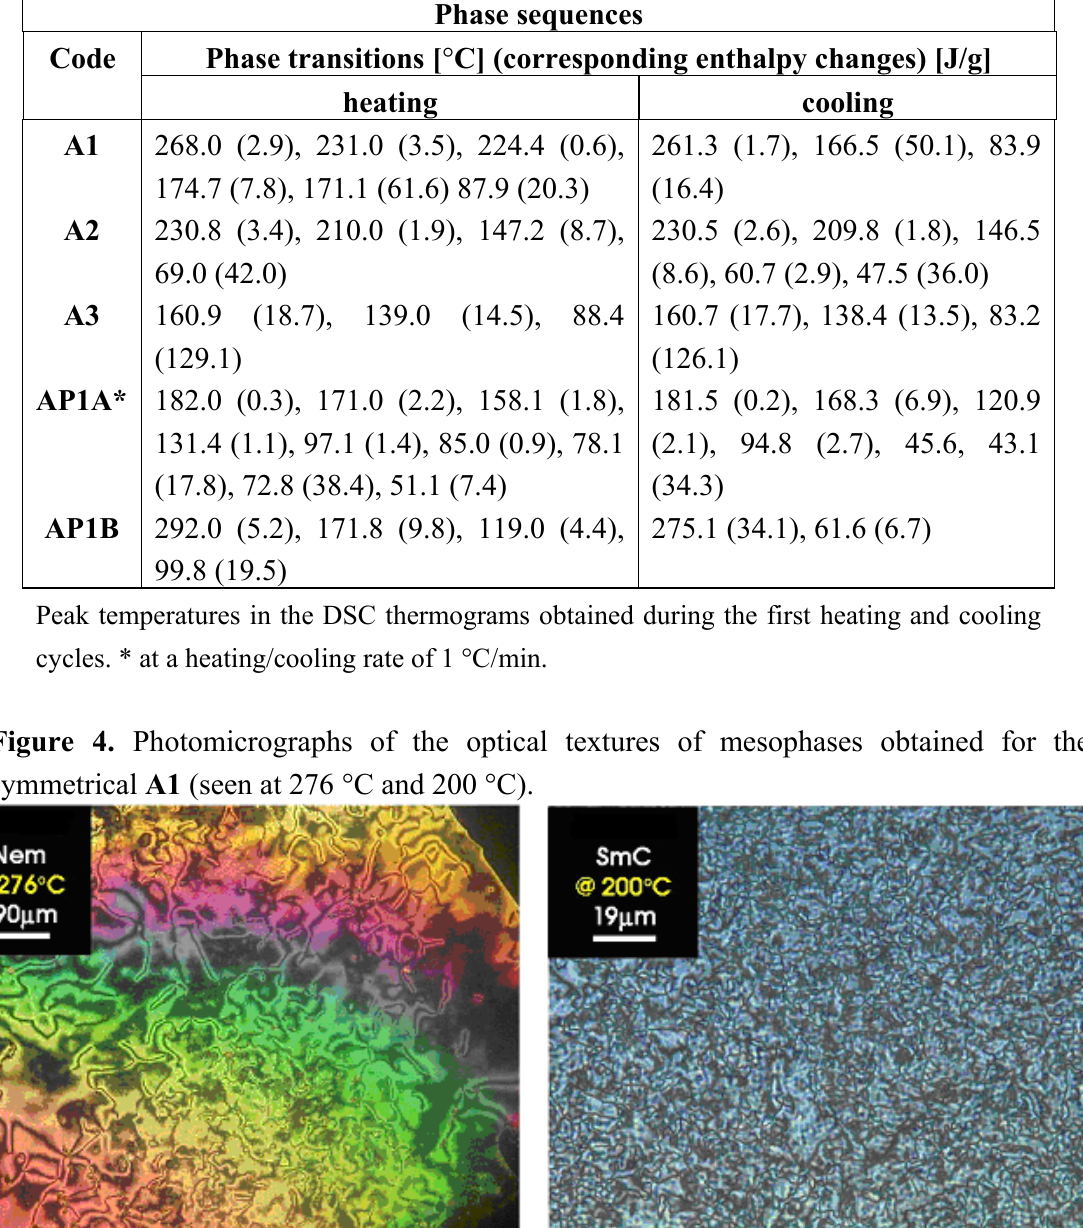
Table 2. Transition temperatures and enthalpies of the symmetrical and unsymmetrical azomethines detected by DSC.